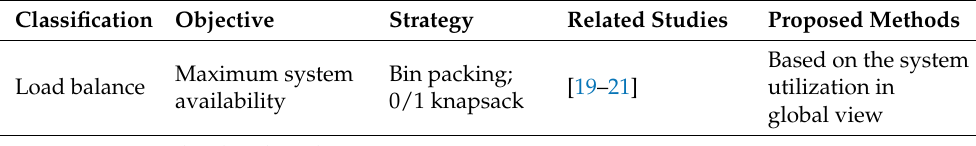
Table 2. Load balancing comparisons with existing